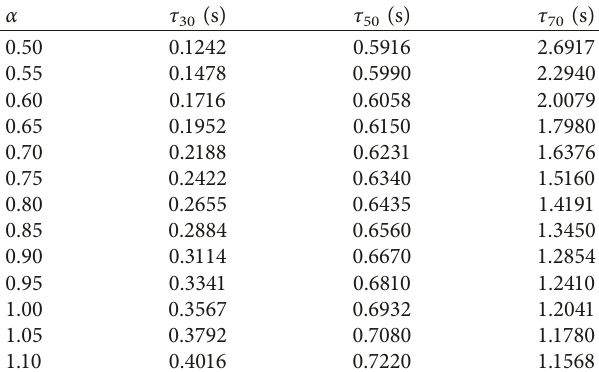
Table 6: Numeric values of normalized times τ 15 , τ 50 , and τ 85 for different values of α